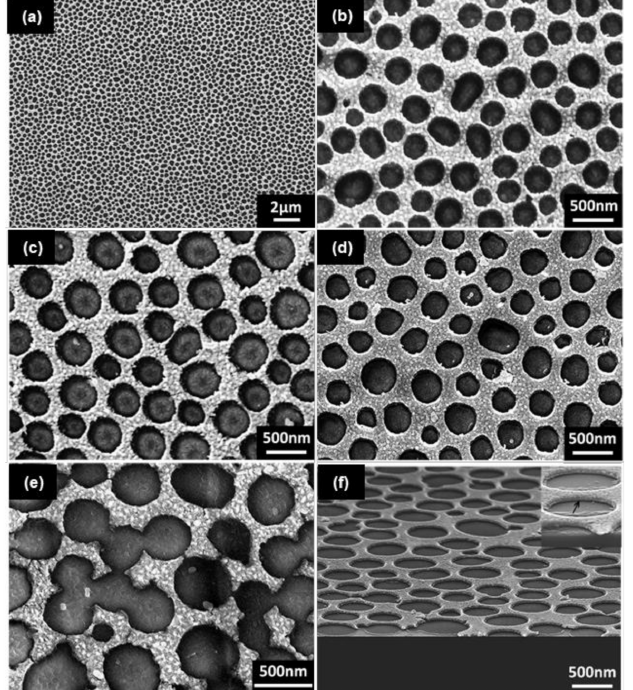
Figure 2. ( a ) SEM image of a large-area interconnected, smooth and uniform Au nanomesh film